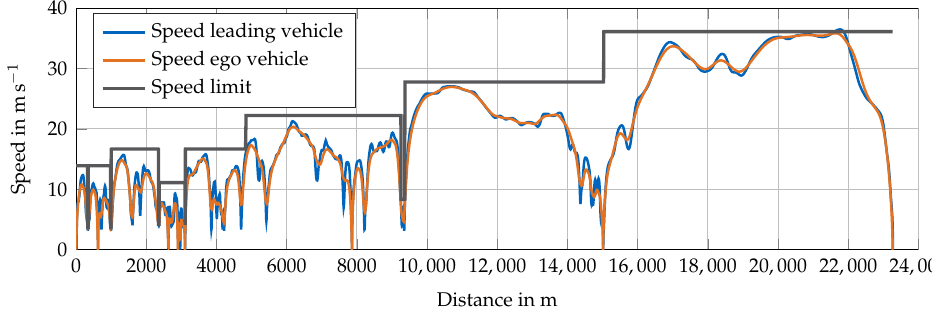
Figure 8. Speed profiles of car-following vehicle and leading vehicle as well as the speed limit.